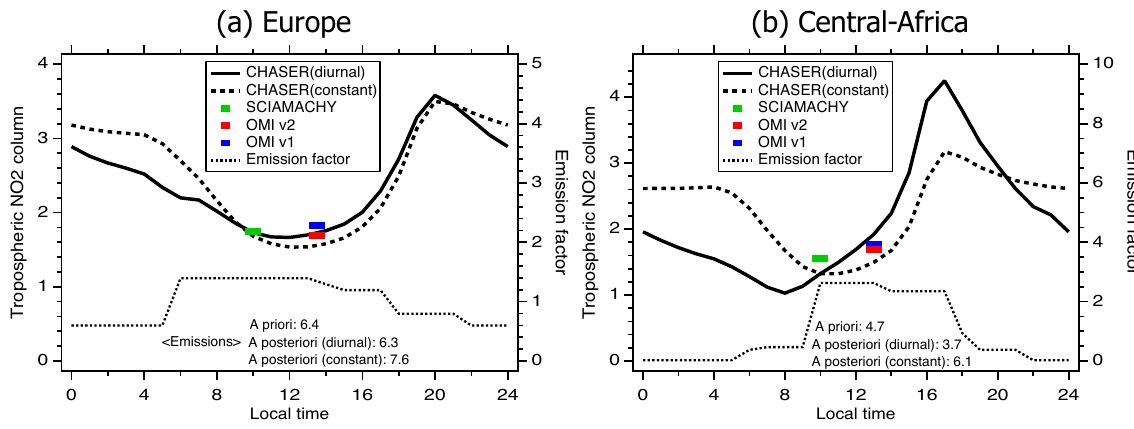
Fig. 4. Monthly mean diurnal variation of tropospheric NO 2 columns (in 10 15 molec . cm − 2 ) obtained from the CHASER simulation with (solid line) and without (broken line) the diurnal variability scheme for surface NO x emissions over (a) Europe (10 ◦ W–30 ◦ E, 35–60 ◦ N) and (b) central Africa (10–40 ◦ E, 20 ◦ S–Equator) in July 2005. Tropospheric NO 2 columns obtained from the satellite retrievals: DOMINO v1 (blue), DOMINO v2 (red), and SCIAMACHY (green) are also plotted. The dotted line represents the diurnal variability factor used for NO x emissions.